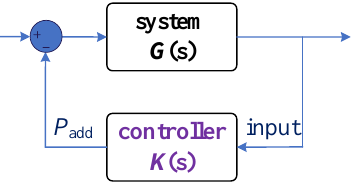
Figure 5. The relationship between the supplementary control and system.